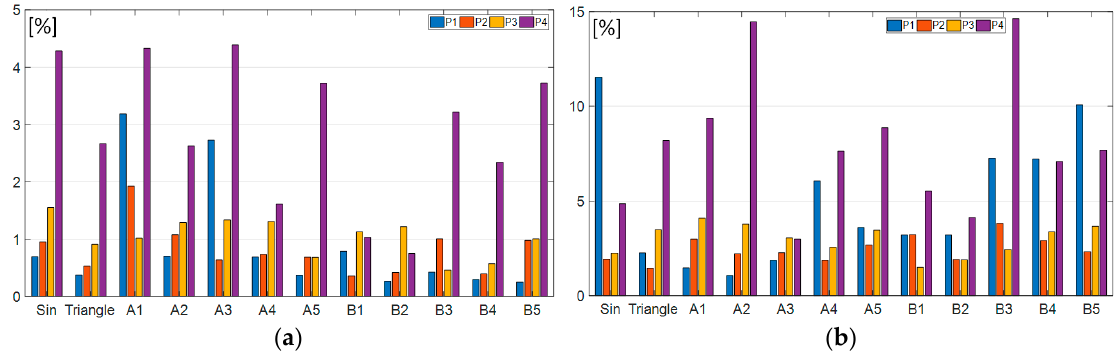
Figure 10. Coefficient of variation for arcing time (CVT) for: ( a ) CI-1 ( b ) CI-2. Figure 10. Coe ffi cient of variation for arcing time (CVT) for: ( a ) CI-1 ( b )